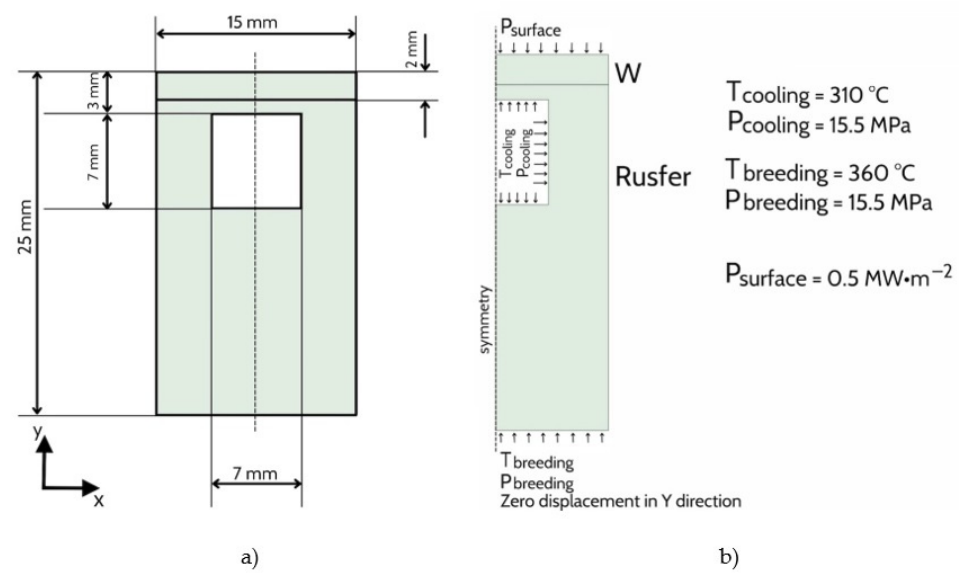
Figure 1. Test component ( a ) and boundary conditions for FEM model ( b ).